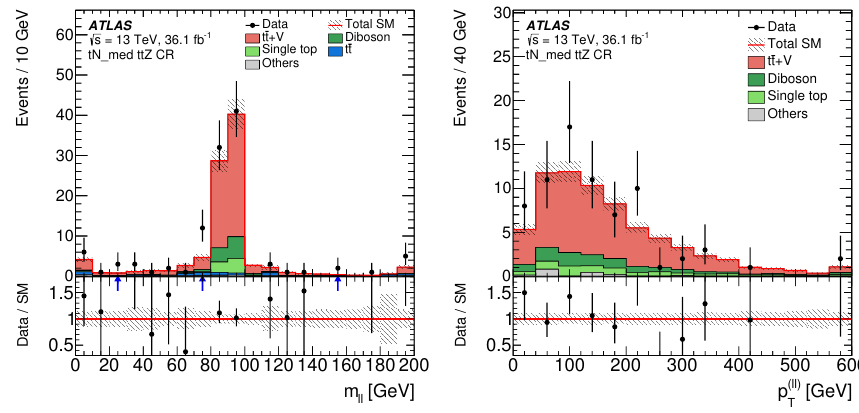
Figure 14 . Distribution of (left) the dilepton mass and (right) p ‘‘ reconstructed Z boson in the t (cid:22) t + Z control region (TZCR) associated with the tN med signal region. The t (cid:22) t + Z=W processes are normalised in the TZCR. The diboson background is normalised to data events with zero b -tagged jets. The hatched area around the total SM prediction and the hatched band in the Data/SM ratio include statistical and experimental uncertainties. The last bin contains